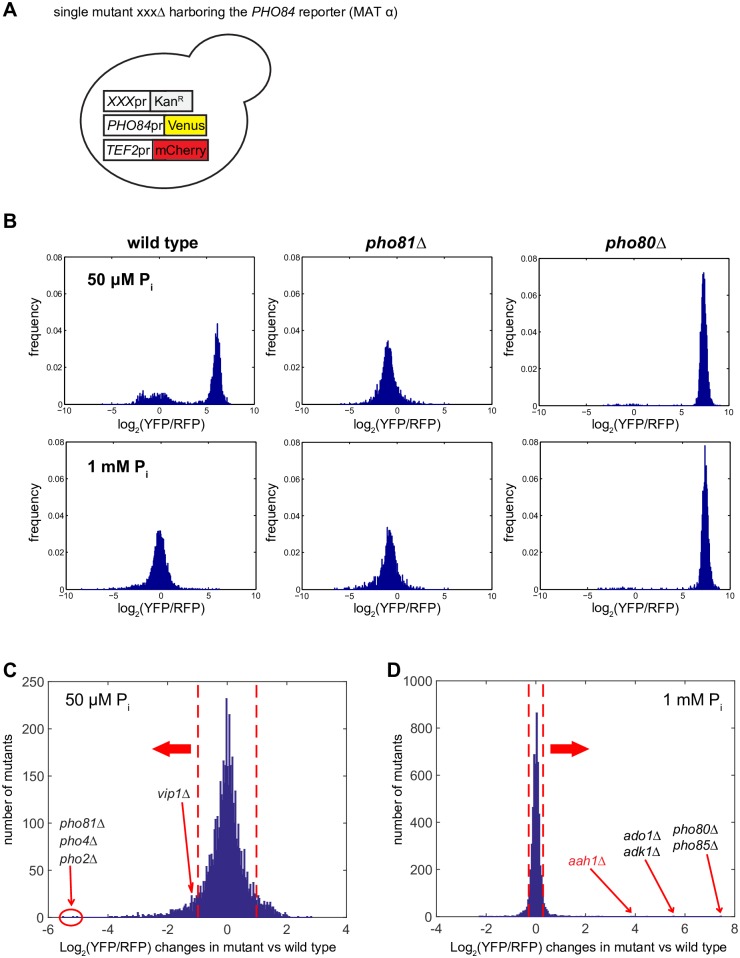
Identification of mutants with altered PHO84 expression in low and high Pi conditions.(A) Generation of single mutants harboring the PHO84 reporter with the SGA method. The PHO84 reporter consists of PHO84 promoter-driven Venus and TEF2 promoter-driven mCherry. Each single mutant in the library denoted by xxxΔ is kanamycin (G418)-resistant. (B) The distributions of the PHO84 reporter levels in single cells in the pho81Δ and pho80Δ strains. Log2 intensity ratio of Venus to mCherry (log2(YFP/RFP)) was used to quantify the PHO84 expression level. (C, D) The PHO84 reporter levels of single mutants in the library measured in 50 μM Pi and 1 mM Pi conditions. The PHO84 reporter level of each mutant was normalized to that of the wild type value in each Pi concentration (Materials and methods). Red dashed lines in (C) and (D) indicate the PHO84 reporter levels with p-values less than 0.001 estimating the maximum range of the PHO84 reporter levels that the wild type exhibits in each Pi concentration. The mutants in black are previously identified mutants and the one in red is identified in this study.